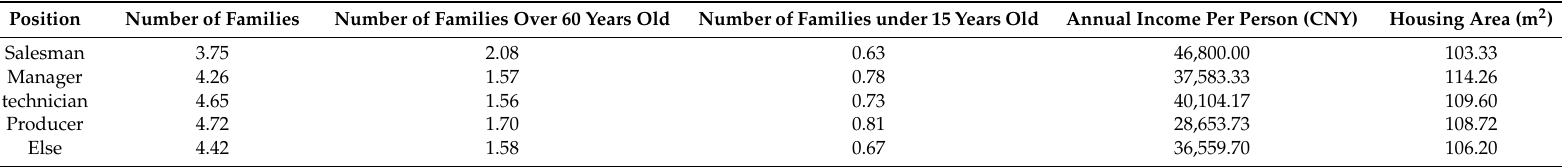
Table 3. Descriptive statistics of relocated employees of chemical enterprises in the Yangtze River Basin (by position